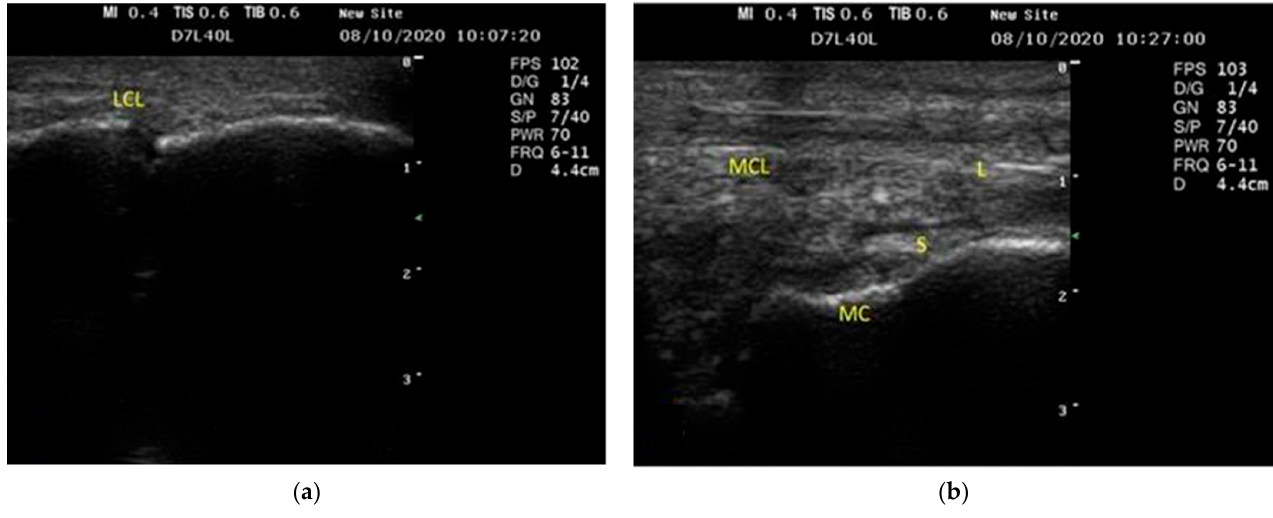
Figure 2. Longitudinal ultrasonographic scan of the lateral ( a ) and medial ( b ) features of the carpal joint in donkeys showed that the lateral collateral ligament (LCL) appears as a thin echogenic band in longitudinal scans. The medial collateral ligament (MCL) seemed like a thick echogenic structure in the US. LCL, lateral collateral ligament; MCL, medial collateral ligament; L, long fibers; S, short fibers; MC, middle carpal bone.